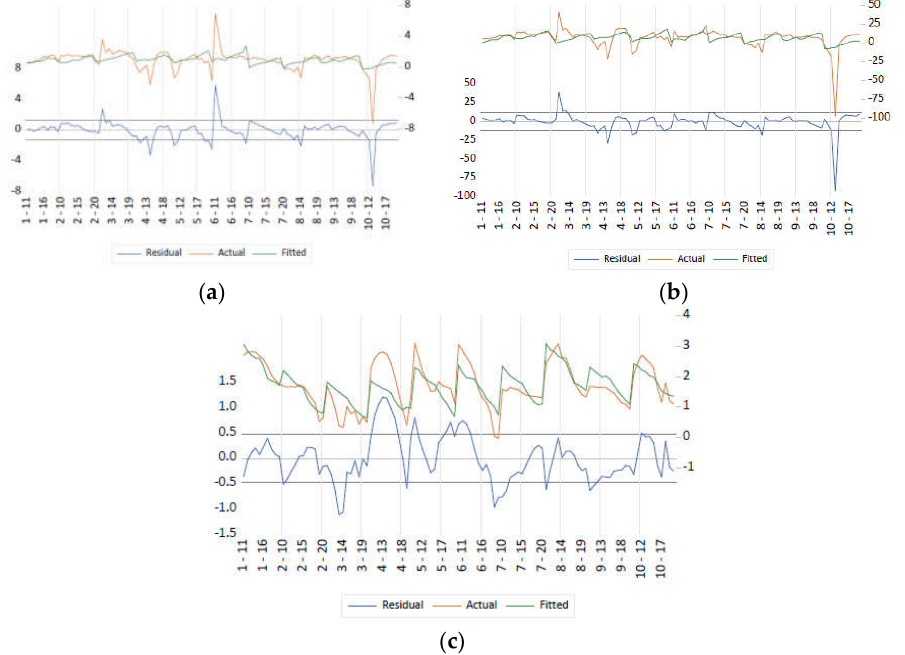
Figure 8. GETS algorithm results for: ( a ) Model 1; ( b ) Model 2; ( c ) Model 3.